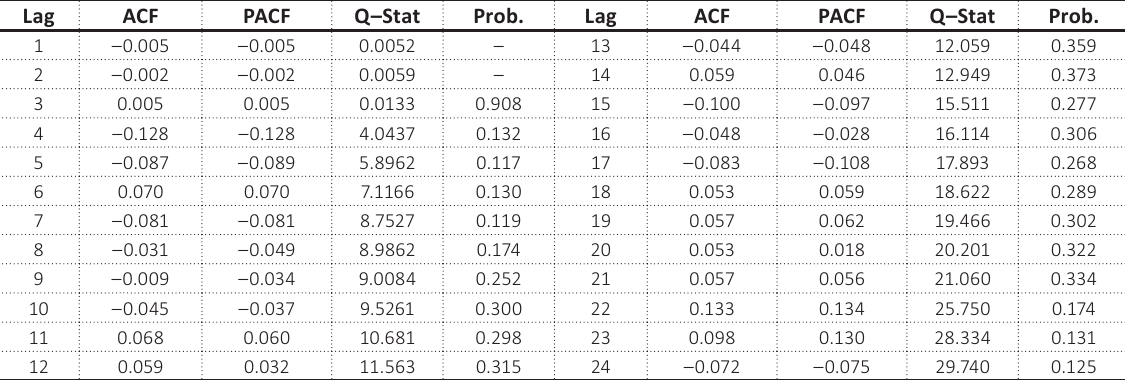
Table A6. Residuals’ ACF for (5-6) final